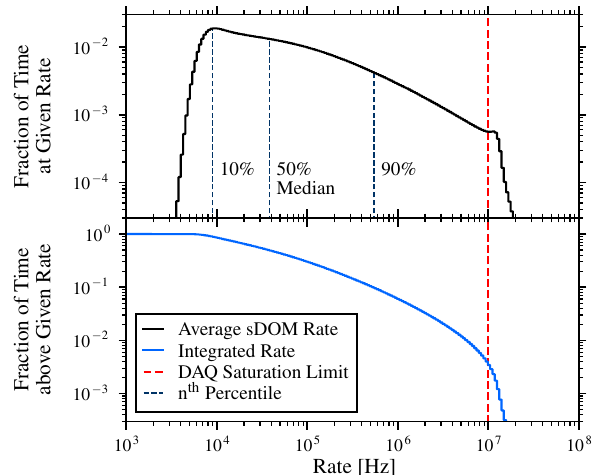
Fig. 11 Distribution of the single-PMT background rates measured over 2 years of STRAW operation. The 10 th ( 9kHz ) , 50 th ( 38kHz ) , and 90 th ( 548kHz ) percentile are shown, their evolution over time is shown in Figs. 12 and 13. The bottom plot shows the integral fraction of time from a given rate to infinity, showing for which fraction of time a certain rate was exceeded